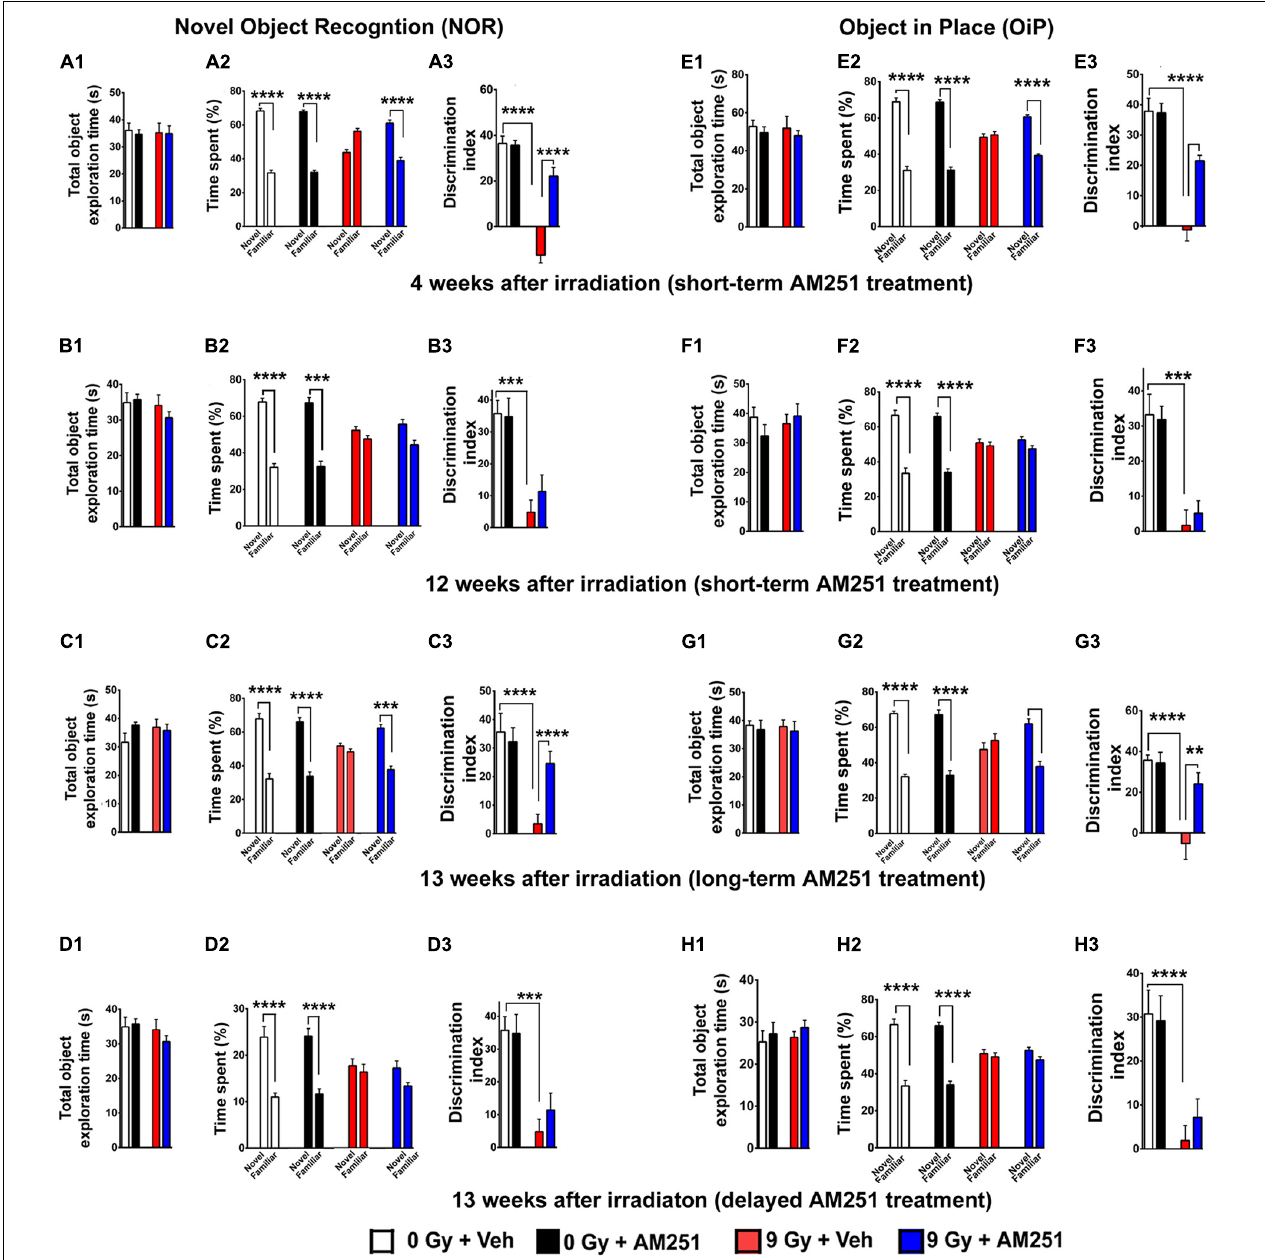
FIGURE 2 | AM251 treatment reverses radiation-induced cognitive dysfunction. NOR: Total exploration time did not differ between all treatment groups (A1–D1) . At 4 weeks postirradiation, the preference for novelty was reduced significantly in irradiated mice, an effect that was ameliorated by short-term AM251 treatment (A2) , evidenced further by follow-up analysis of the DI (A3) . However, this same short-term AM251 treatment was unable to maintain efficacy 12 weeks following irradiation (B2) . While radiation-induced decrements persisted, the benefits of AM251 waned over this extended interval (B3) . Nonetheless, long-term AM251 treatments were found to maintain neurocognitive benefits (C2) , where radiation-induced decrements in the DI measured 13 weeks afterward were ameliorated significantly by AM251 (C3) . Delayed AM251 treatment was not effective in resolving radiation-induced cognitive deficits 13 weeks postirradiation (D1–D3) . OiP: Similarly, irradiation and/or AM251 treatment had no effect on total exploration time in the OiP task (E1–H1) . At 6 weeks following irradiation, the preference for novelty was reduced significantly in irradiated mice, which was ameliorated by short-term AM251 treatment (E2) , as indicated further by subsequent analysis of the DI (E3) . When this same short-term AM251 treatment was assessed 12 weeks later, radiation-induced deficits persisted while AM251 failed to show efficacy (F2–F3) . Long-term AM251 treatments were again found to restore neurocognitive benefits 13 weeks following irradiation (G2) , where radiation-induced deficits in the DI found 13 weeks later were ameliorated significantly by AM251 (G3) . Delayed AM251 treatment was not found to be effective in improving behavioral performance on the OiP task 13 weeks after irradiation (H1–H3) . Data presented as means ± SEM, N = 8–12. P -values for total exploration time (A1–D1) and DI (E1–H1) were derived from two-way ANOVA followed by Bonferroni correction for multiple comparisons. While three-way ANOVA following Sidak post hoc analyses was carried out using time spent exploring novel/familiar object × irradiation (A2–D2;E2–H2) . ** P < 0.01; *** P < 0.001; and **** P < 0.0001.